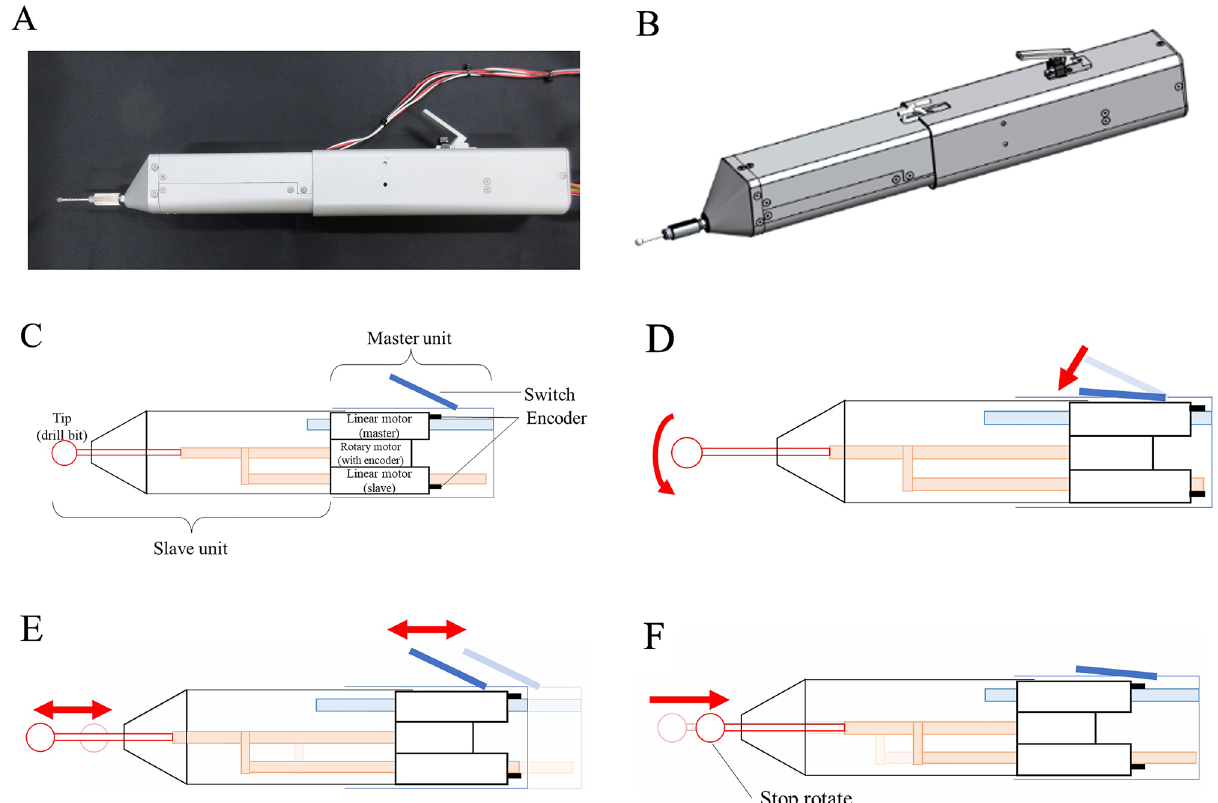
Figure 1. Custom-made surgical drill. ( A ) Clinical image of the custom-made surgical drill. ( B ) Schematic view of the custom-made surgical drill. ( C ) Description of the control unit of the custom-made surgical drill. ( D ) Schematic view of the switching motion. ( E ) Schematic view of the bilateral motion. ( F ) Schematic view of the automatic stop function after detecting